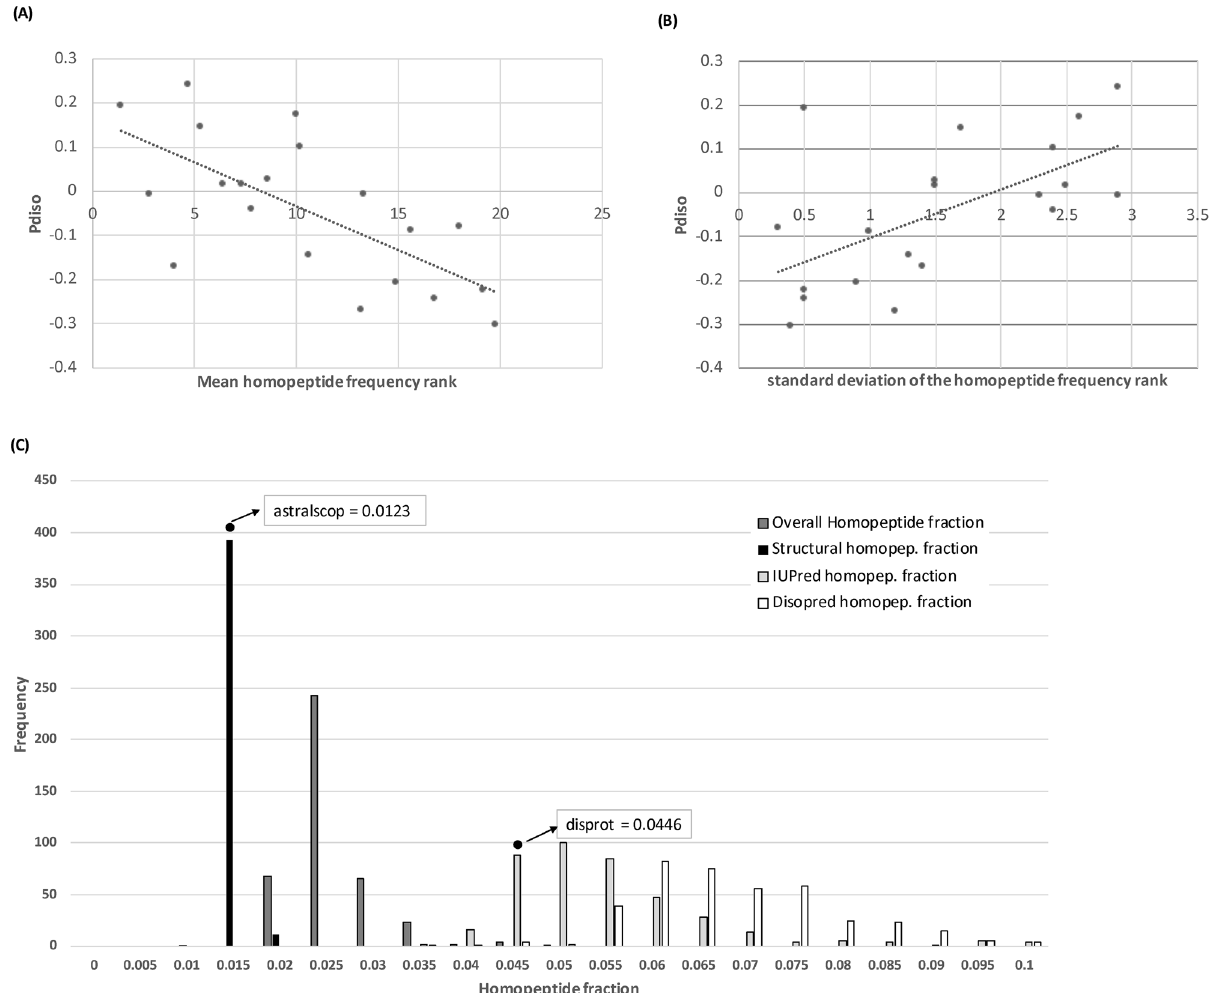
Figure 5. Intrinsic disorder propensity. The intrinsic disorder propensity ( P diso ) of the amino acids is plotted against ( A ) the mean frequency rank across proteomes of the amino acids in homopeptides (Pearson correlation coefficient R = −0.69, P = 0.0008), and ( B ) the standard deviation of the frequency rank of the amino acids in homopeptides (R = 0.60, P = 0.005). In part ( C ), histograms are depicted of the homopeptide fractions of structured regions (annotations made using SCOP domains), and of the IUPred and DISOPRED intrinsic disorder annotations, with the distribution of the overall homopeptide fractions in the proteomes for comparison. The fractions of homopeptides for disordered regions and for structured regions are calculated as fractions of the total number of residues in the disordered and structured subsets of residues respectively. Also indicated on the plot as points are the homopeptide fractions for the ASTRALSCOP40 and DISPROT